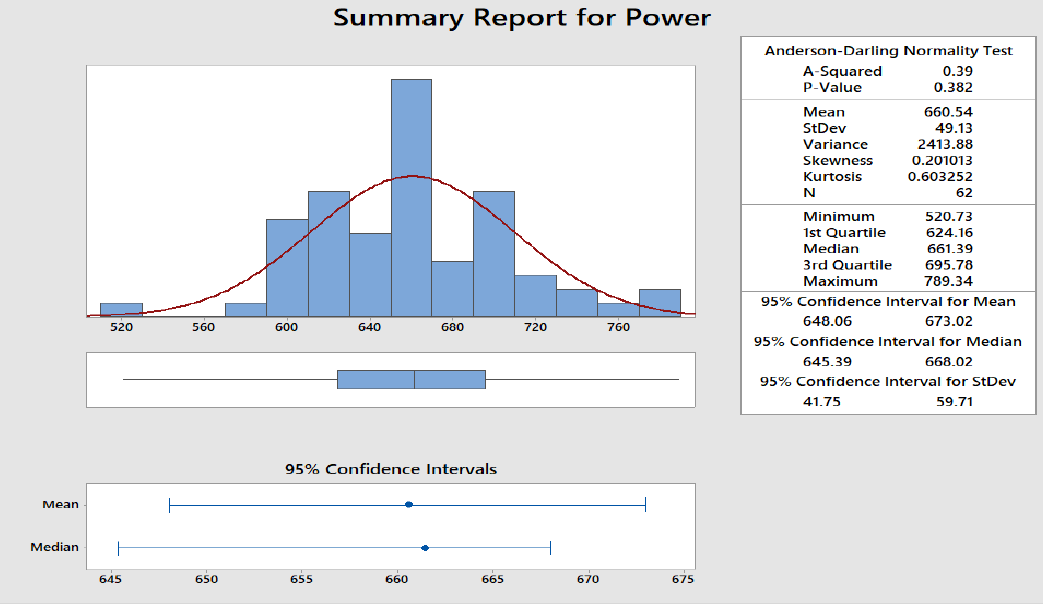
Figure 6. Anderson-Darling normality test for Dhahran wind.